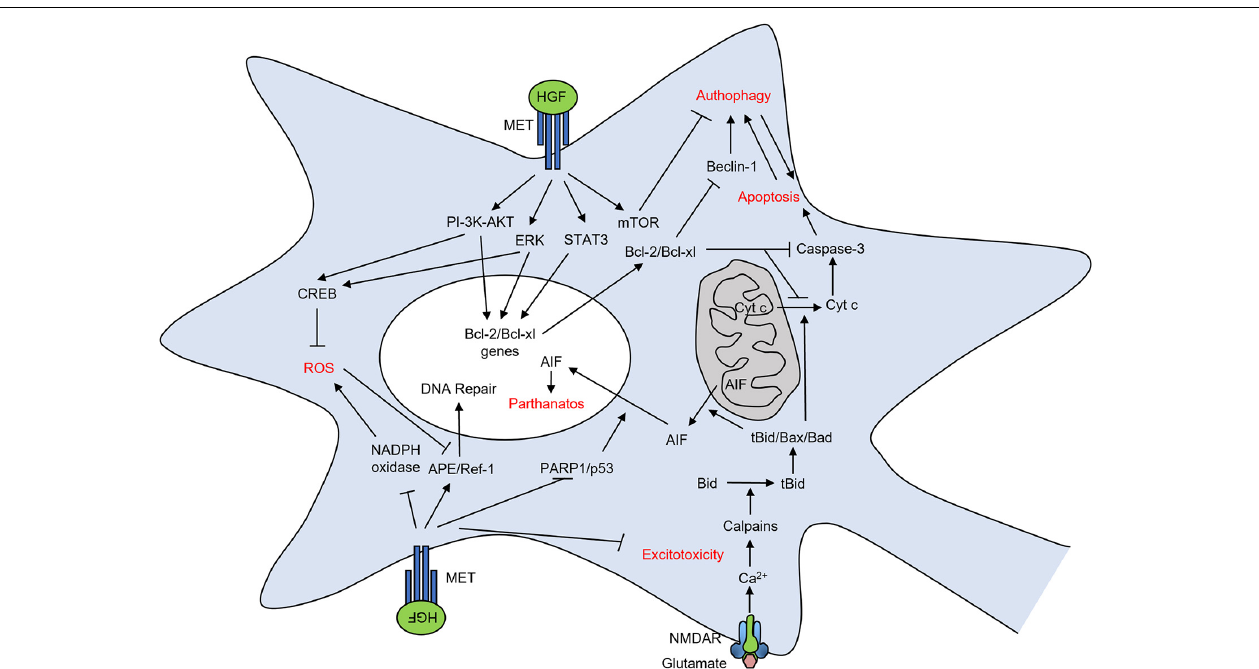
FIGURE 4 | HGF-MET pair protects neurons from death after brain damage. Representation of signaling mechanisms through which HGF-MET prevents oxidative stress, excitotoxicity, apoptosis, autophagy, and parthanatos in